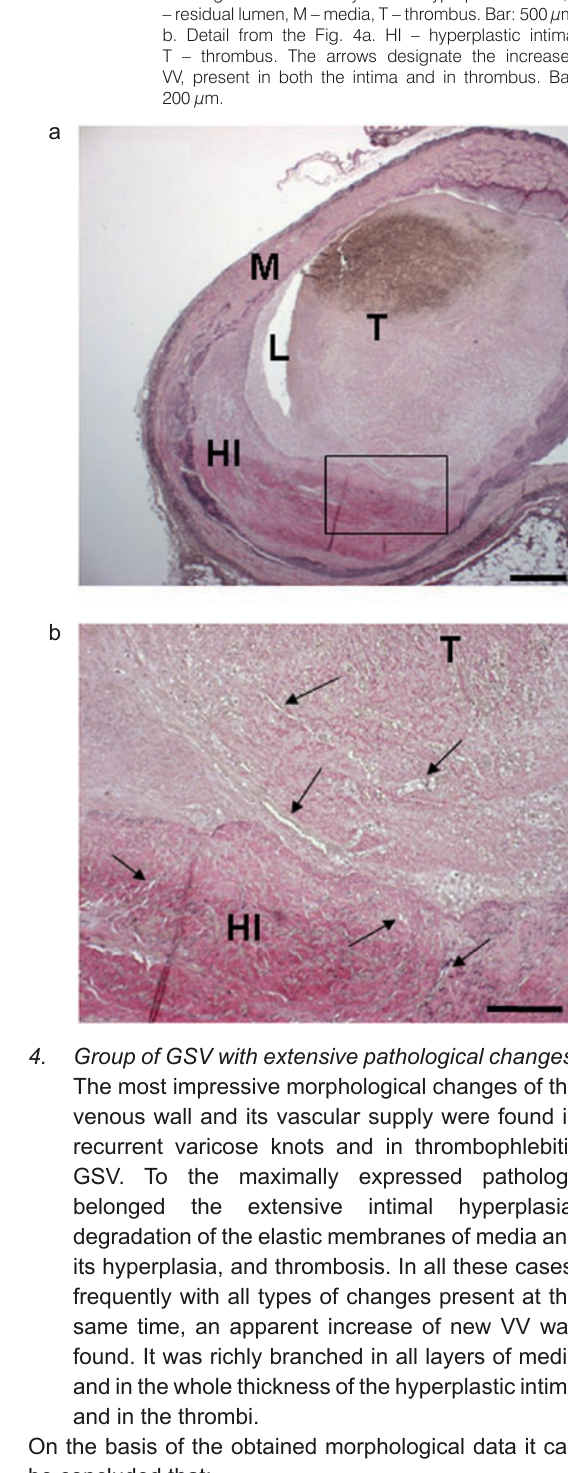
Figure 4. a. Cross section of the wall of recurrent varicose knot, nearly completely closed by an organized thrombus. Staining for elastin. HI – layer of the hyperplastic intima, L – residual lumen, M – media, T – thrombus. Bar: 500 μm. b. Detail from the Fig. 4a. HI – hyperplastic intima, T – thrombus. The arrows designate the increased VV, present in both the intima and in thrombus. Bar: 200